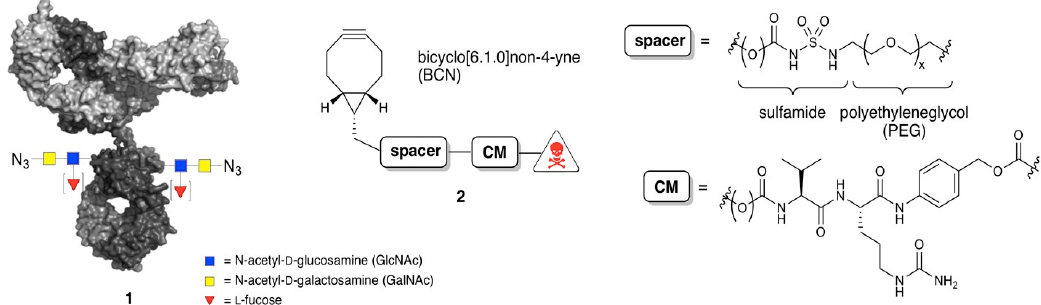
Figure 1. Generic structures of azidosugar-functionalized antibody ( 1 ) and BCN-spacer-CM-payloads ( 2 ). The spacer may consist solely of a polyethyleneglycol (PEG) chain or may be additionally modified, as described herein, with acyl/carbamoyl sulfamide (jointly called HydraSpace™). Val-Cit- p -aminobenzyloxycarbonyl (vc-PABC), as